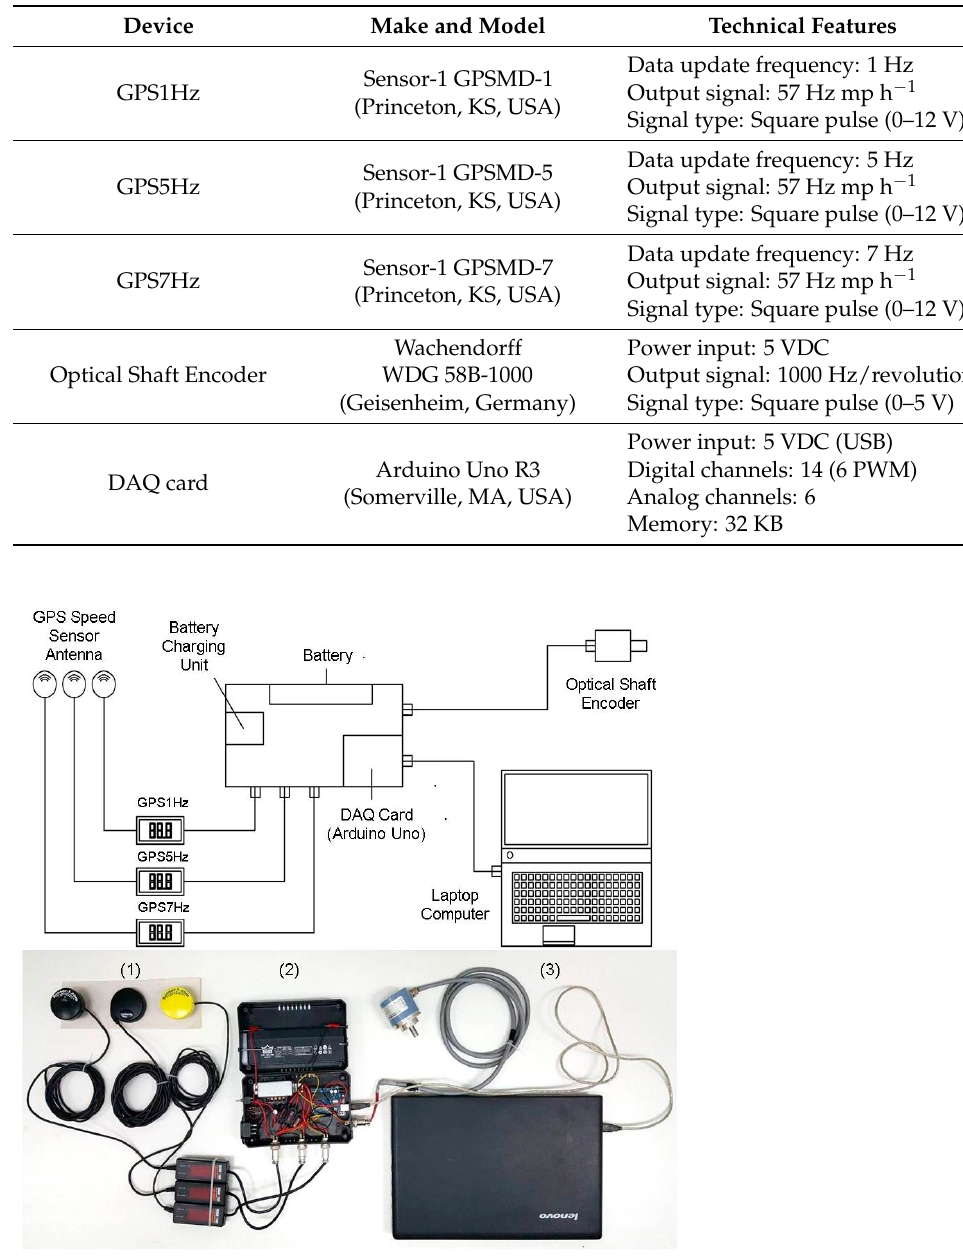
Figure 2. Hardware used in the study (( 1 ) Three GPS speed sensors, ( 2 ) DAQ card and other cir- cuitry, ( 3 ) Optical shaft encoder and computer) (drawing not to scale). ( 3 ) Optical shaft encoder and computer) (drawing not to